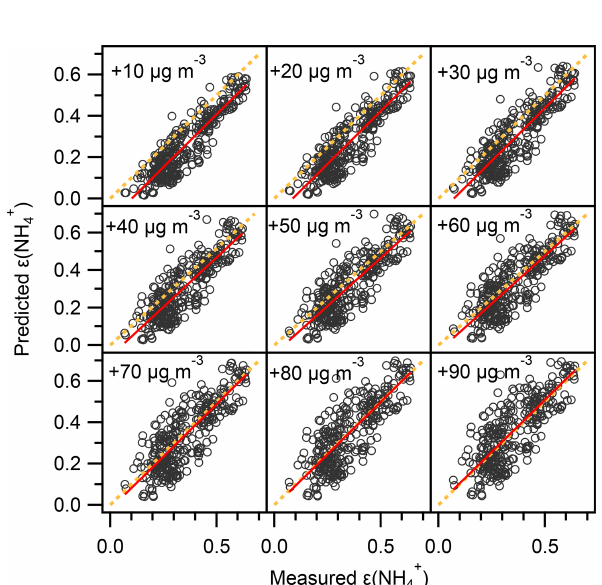
Figure 7. Comparison of predicted and measured ε (NH + the predicted ε (NH + ) was analytically calculated using Eq. (1) with 4 γ H + input (i.e., pH, AWC, ) taken from ISORROPIA II prediction, γ NH + 4 and the AWC has been increased by 10 and 20 to 90µgm − 3 while other inputs are fixed. The orthogonal distance regression (ODR) fit line (red) and y = x line (dashed orange) are shown for the clarity of the figure.